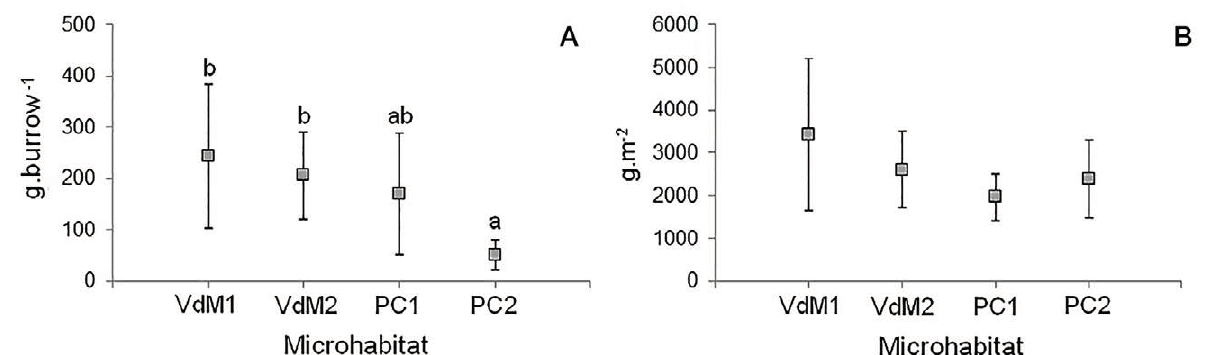
Fig. 4. – Dry sediment from biogenic mounds. A, of an individual burrow. B, in 1 m 2 , in the different microhabitats. Mean and standard devia- tion are shown. Tukey test (same letters indicate that there are no significant differences, α =0.05).